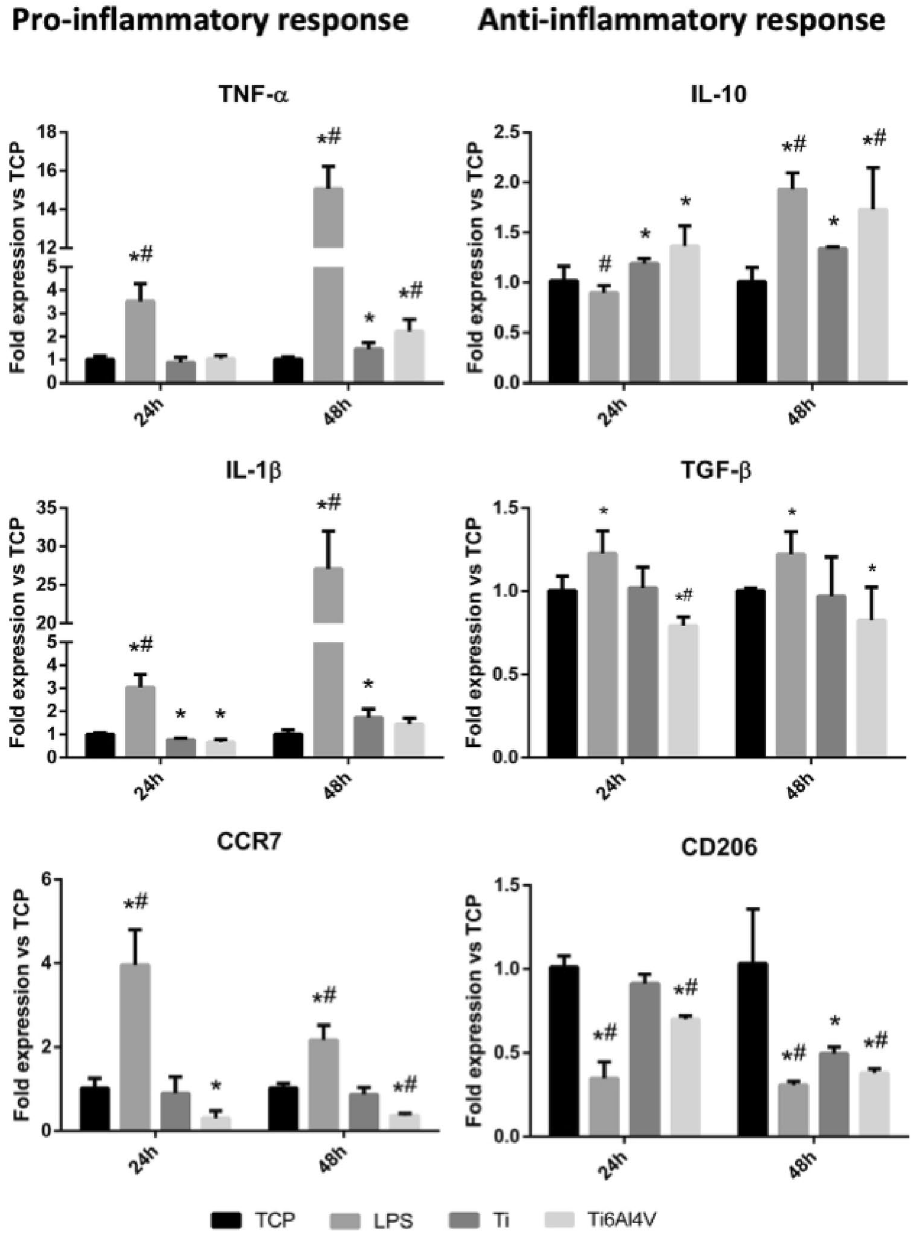
Figure 2. Effect of stimulation with Ti and Ti6Al4V alloy extracts upon gene expression of proinflammatory (TNF-α, IL-1β and CCR7) and anti-inflammatory markers (IL-10, TGF-β and CD206) in the THP-1 macrophage cell line. Statistically significant differences ( p < 0.05) are represented with * when comparison was made versus TCP and with the symbol # when comparison was made versus